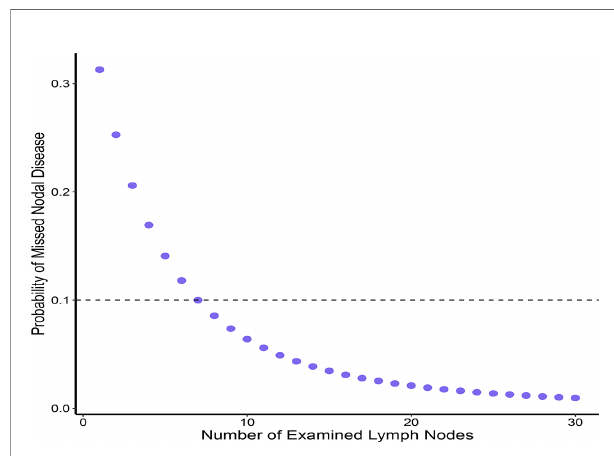
FIGURE 2 | Probability of missed nodal disease as a function of the number of LNs examined.